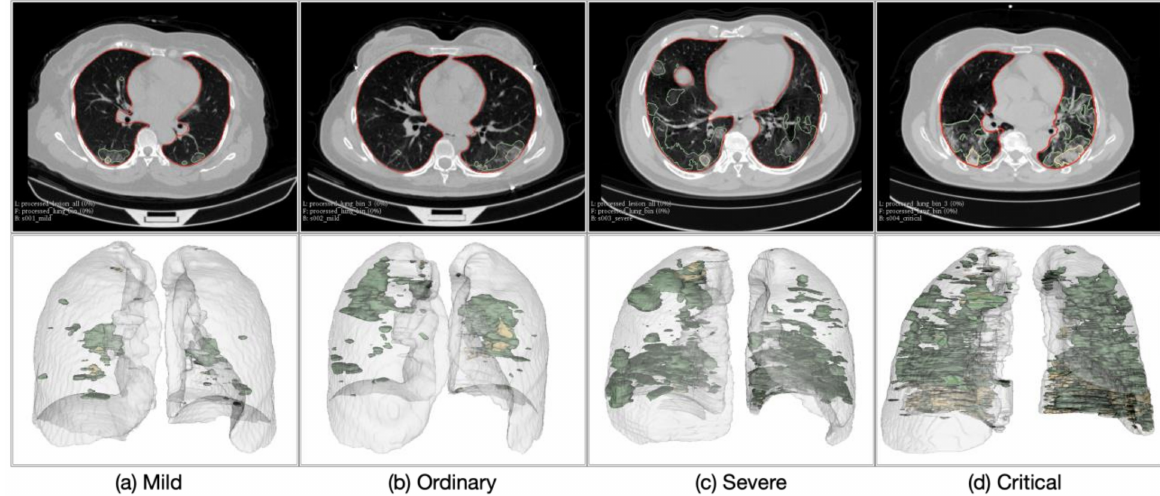
Figure 4. Examples of the patients in different severity groups: ( a – d ). The upper row presents the axial CT slices with the lung (red) and lesion (green: GGO; yellow: consolidation; brown: pleural effusion) boundaries overlaid on the CT slices. The lower row illustrates the 3D models of the lung and lesions.